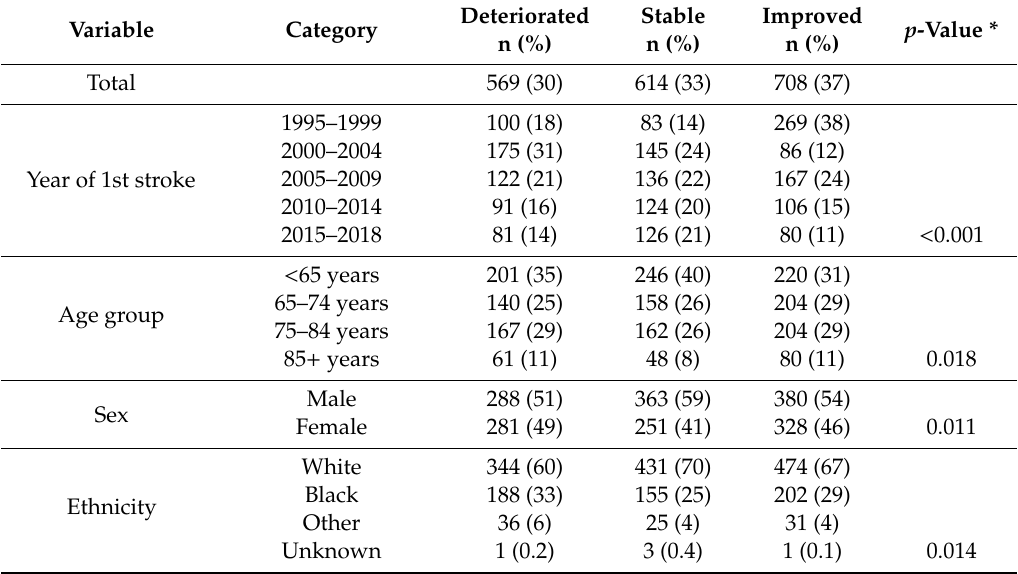
Table 4. Baseline measures by change in cognitive impairment between seven days and three